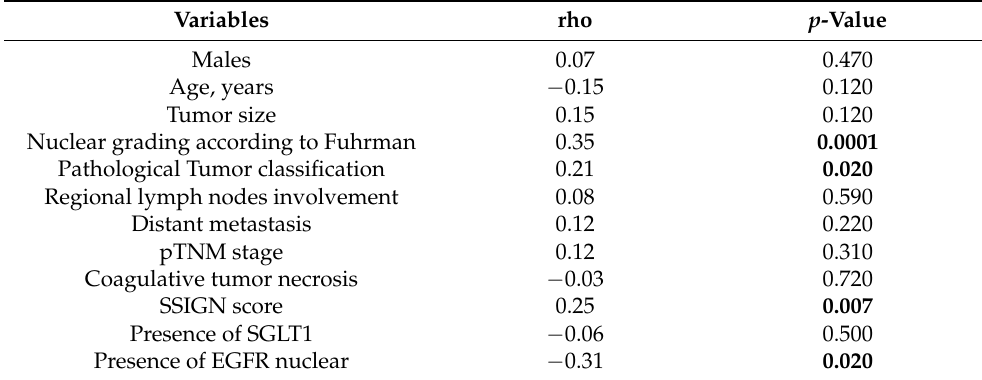
Table 2. Correlation between EGFR total score and clinico-pathological features of patients with CCRCC.